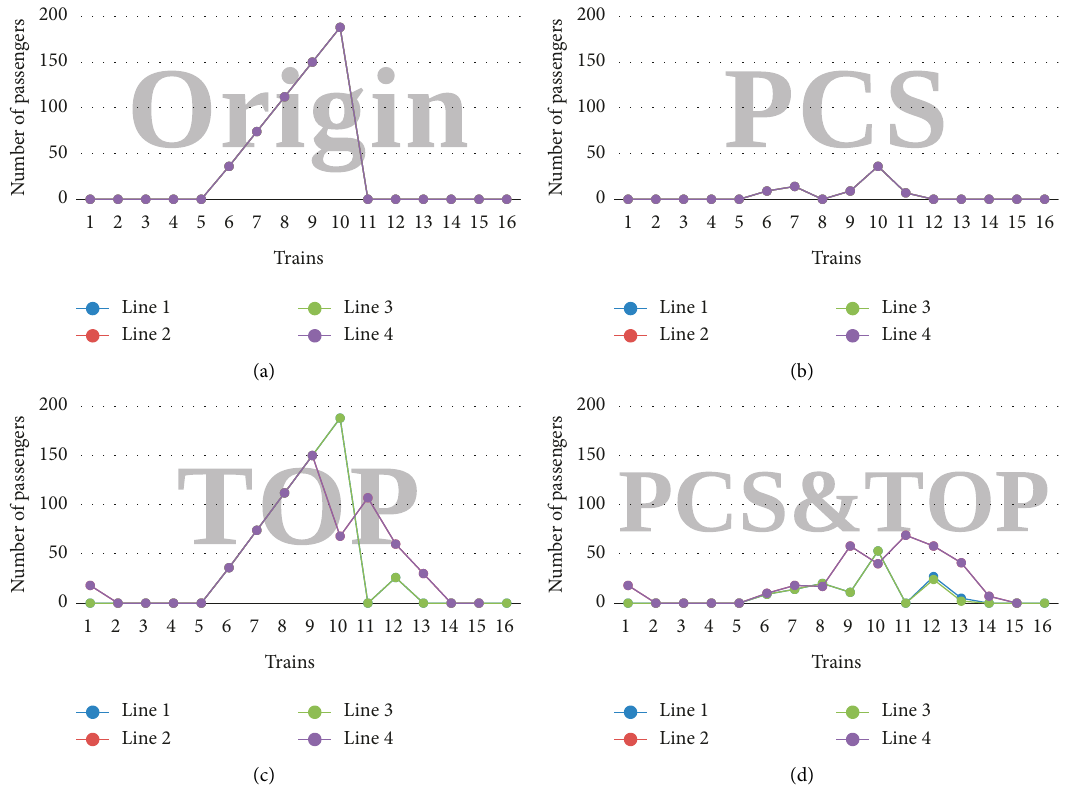
Figure 7: The number of left-behind passengers in different solutions. (a) Origin solution; (b) PCS solution; (c) TOP solution; and (d) PCS&TOP